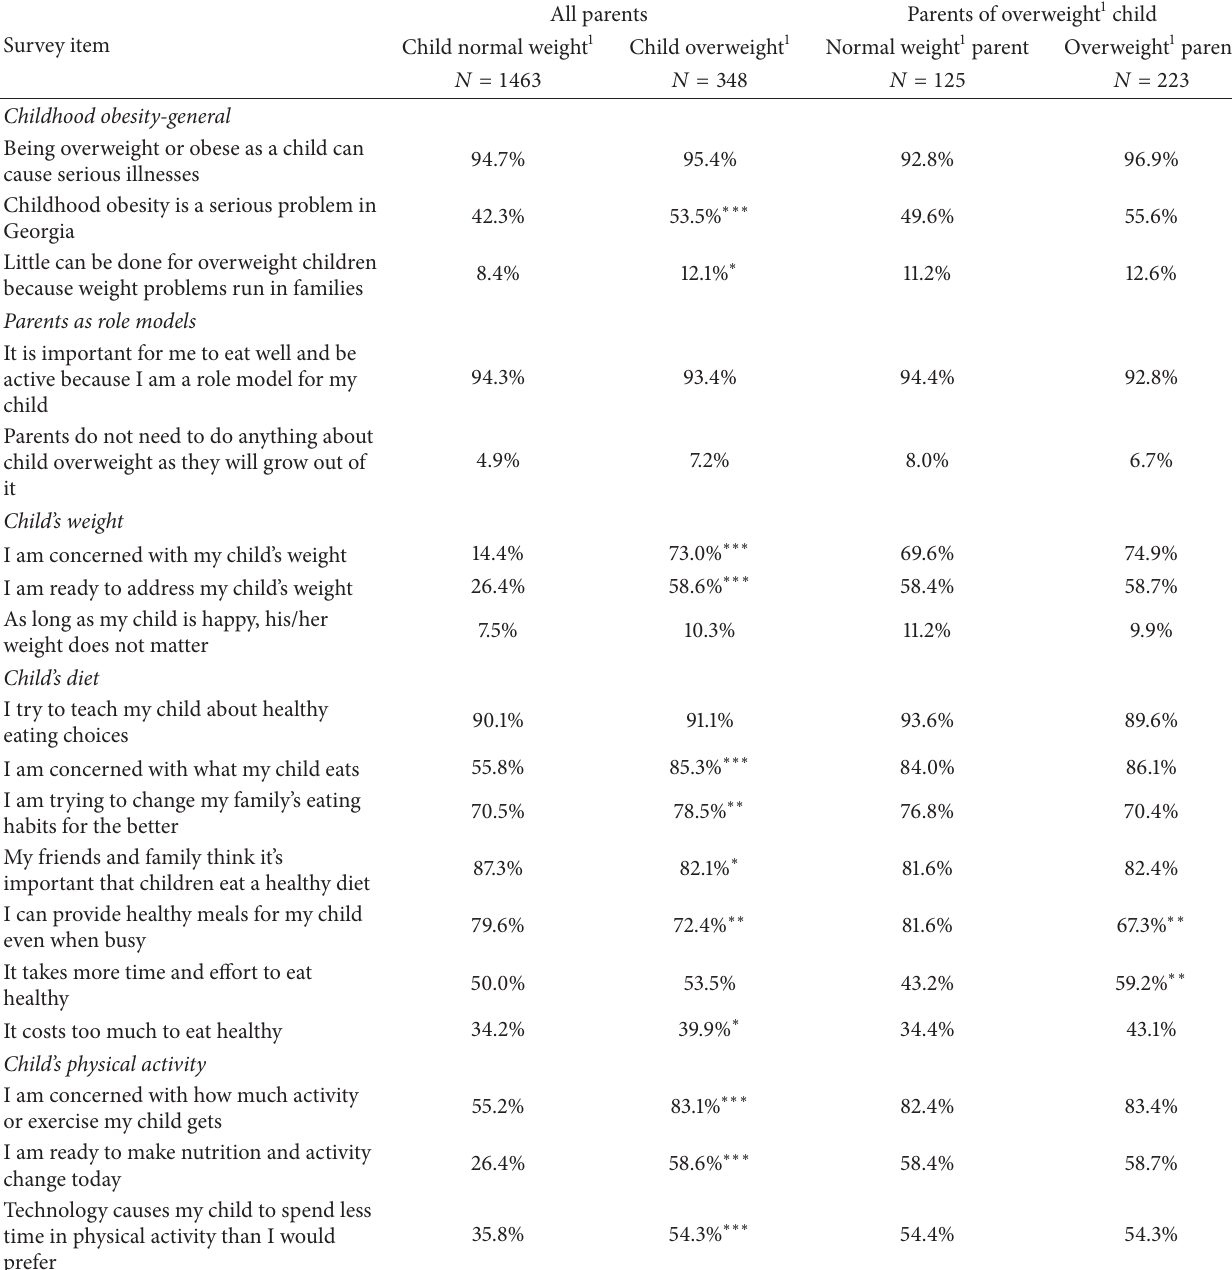
Table 2: Proportion of parents agreeing with statements related to childhood obesity, diet, and physical activity stratified by child and parent weight status (as perceived by